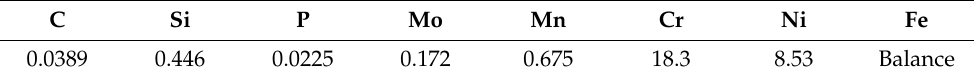
Table 1. Chemical composition of the AISI 304 stainless steel (wt.%).